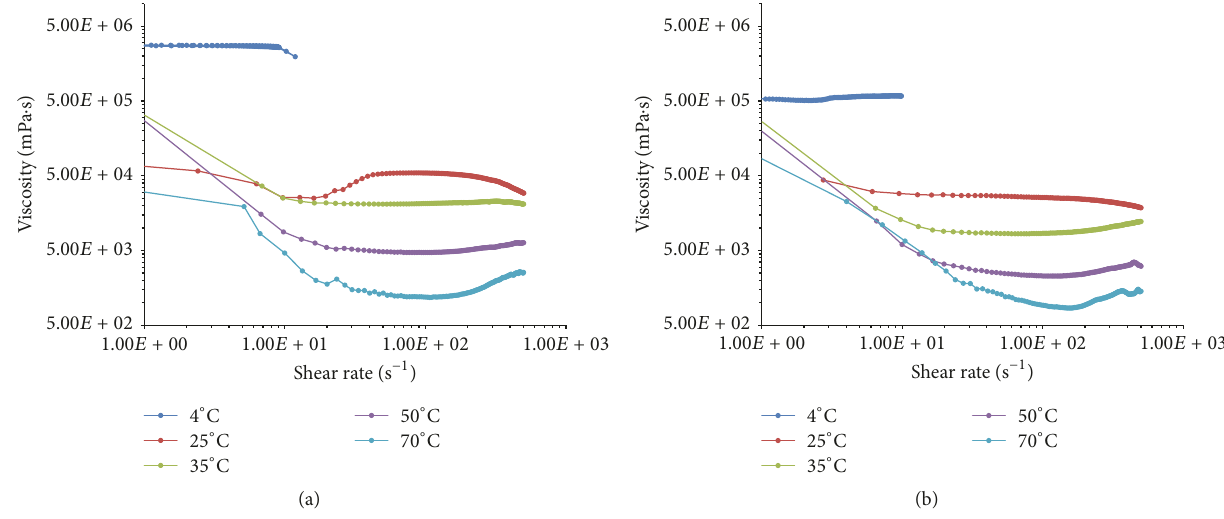
Figure 2: Viscosity curves of OsLu (a) and Vivinal GOS (b) at different temperatures: 4, 25, 35, 50, and 70 ∘